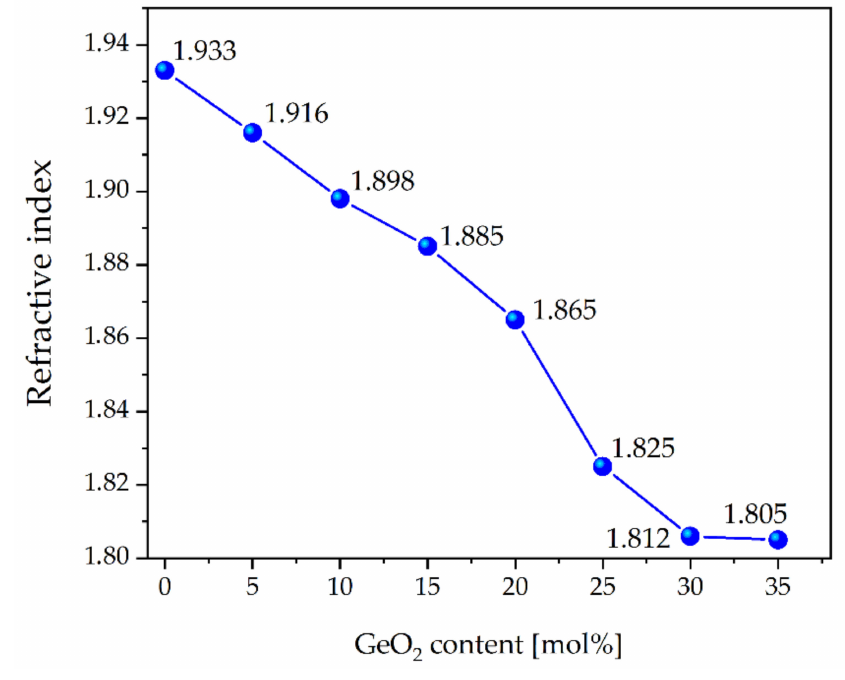
Figure 8. Refractive index of Eu 3+ -doped tellurite